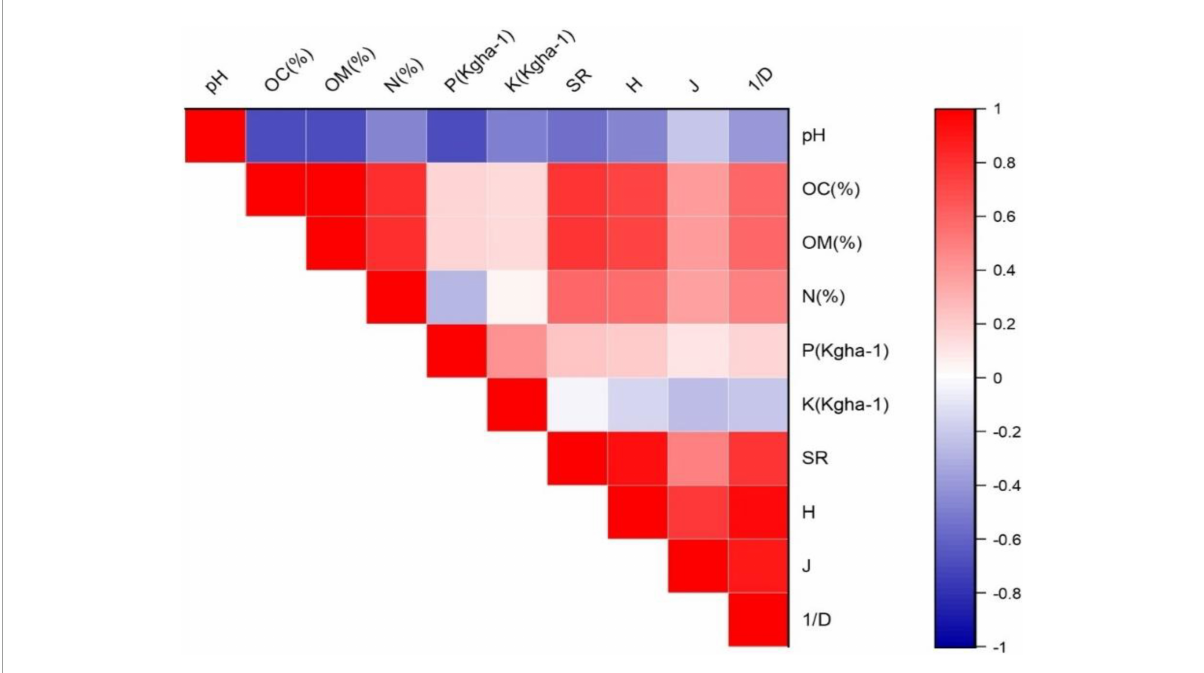
FIGURE3 Correlation plot between vegetation and soil parameters. Statistical significance p <